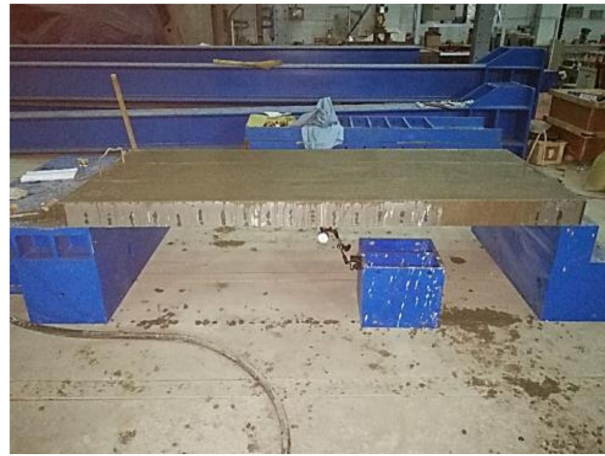
Figure 5. Entity image of composite floor.